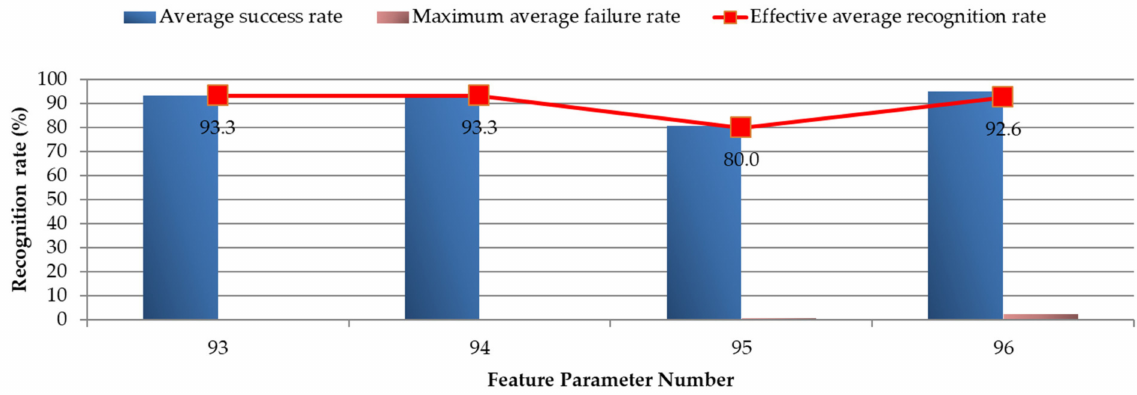
Figure 37. GIS-3 partial discharge parametric: cross-correlation coefficient recognition rate.